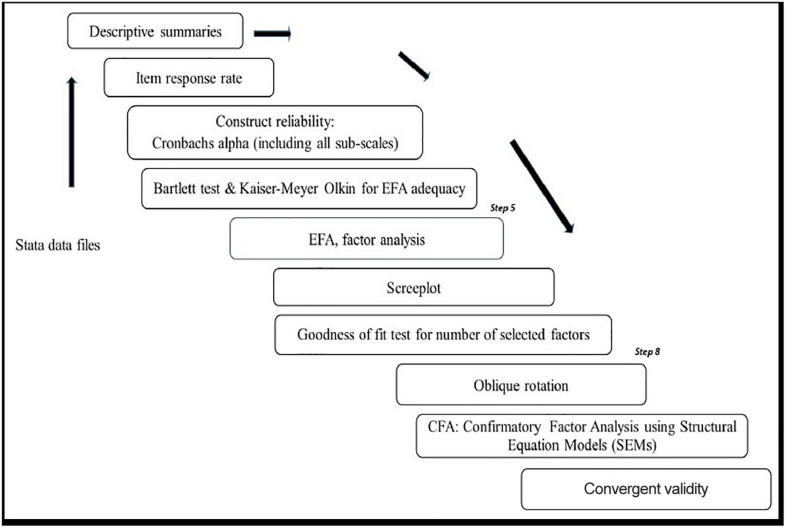
Summary of data analysis process.